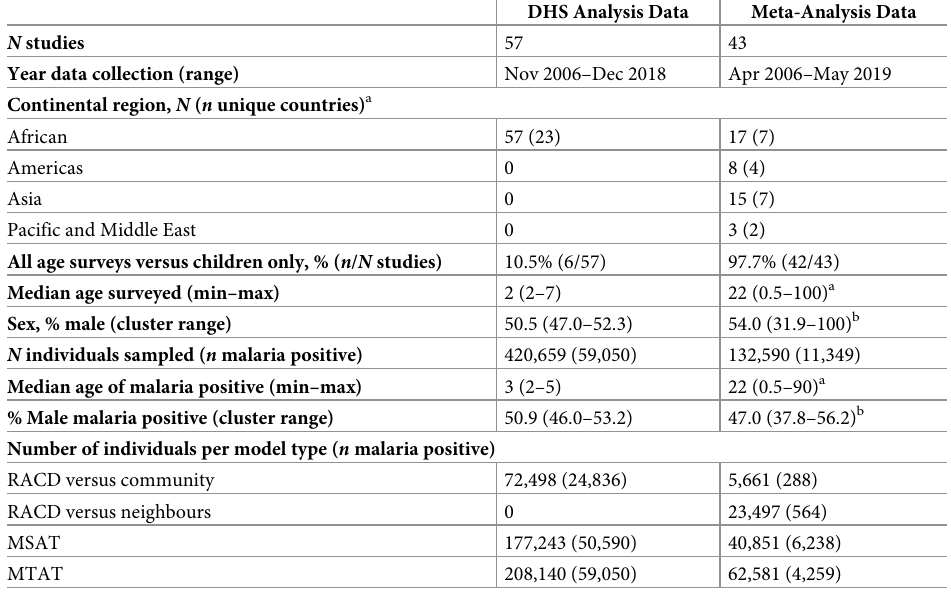
Table 2. Summary information providing an overview of the data included in the data analysis using the DHS data and published literature included in the